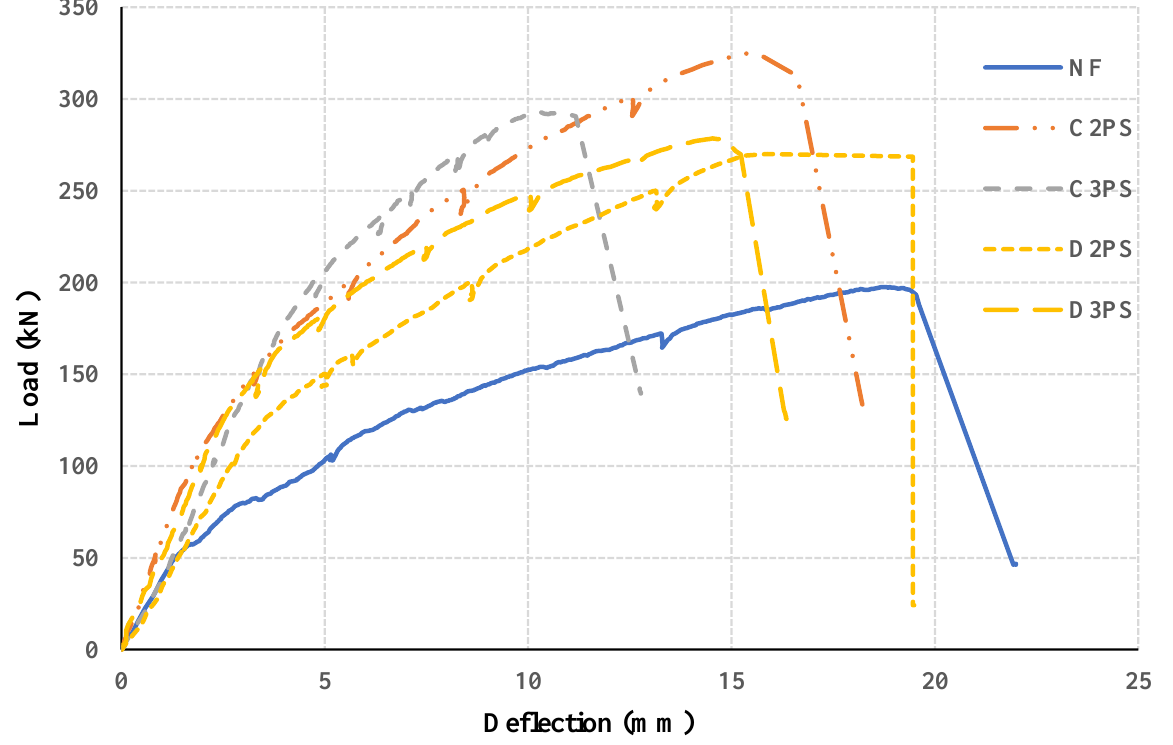
Figure 6. Load – deflection response of all tested specimens. Figure 6. Load–deflection response of all tested specimens.